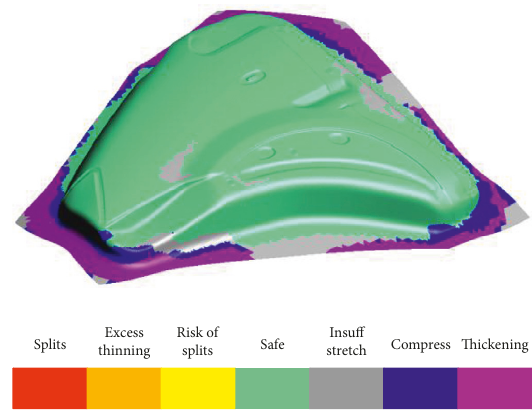
Figure 8: Thinning rate simulation result.